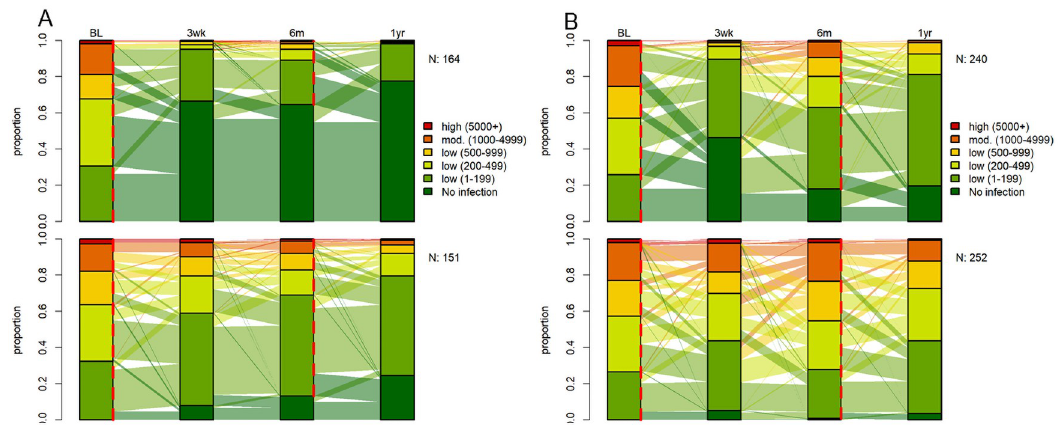
Fig 2. Proportion of infection intensities of T . trichiura at baseline, 14–21 days, six and 12 months post-treatment in Lao PDR (A) and Pemba Island (B) for ivermectin-albendazole above and albendazole-placebo below. 315 participants in Lao PDR and 492 participants on Pemba Island had a complete data set. Red dashed lines at baseline and follow up represent treatment time points. Abbreviations: BL, baseline assessment; N, number of participants with a complete data set; 3wk, 14–21 days post-treatment follow-up; 6m, 6 months post-treatment follow-up; 1yr, 12 months post-treatment follow-up.